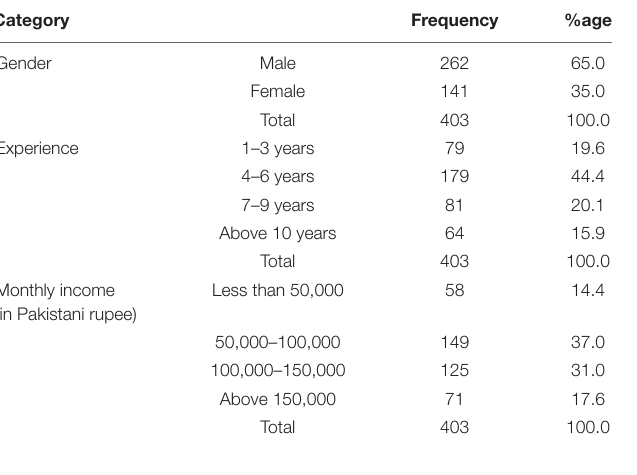
TABLE 1 | Respondent’s